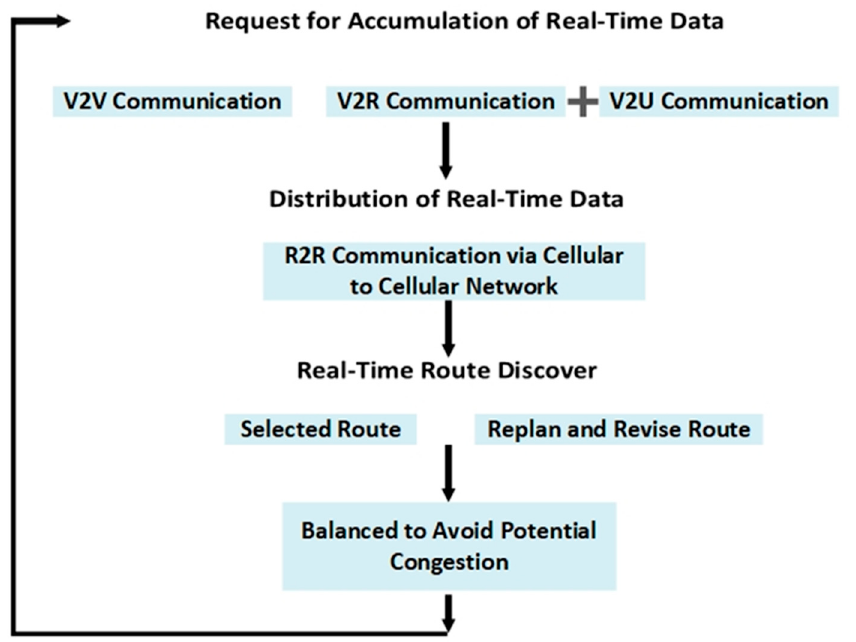
Figure 2. Transportation network architecture.